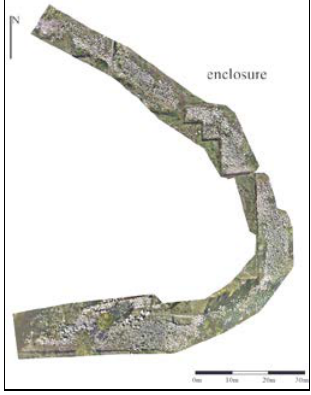
Figure 18. The UAV- helicopter used for image acquisition.